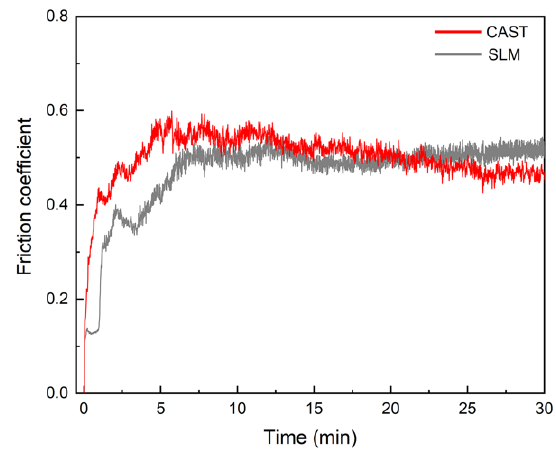
Figure 6. Friction coefficient curves.